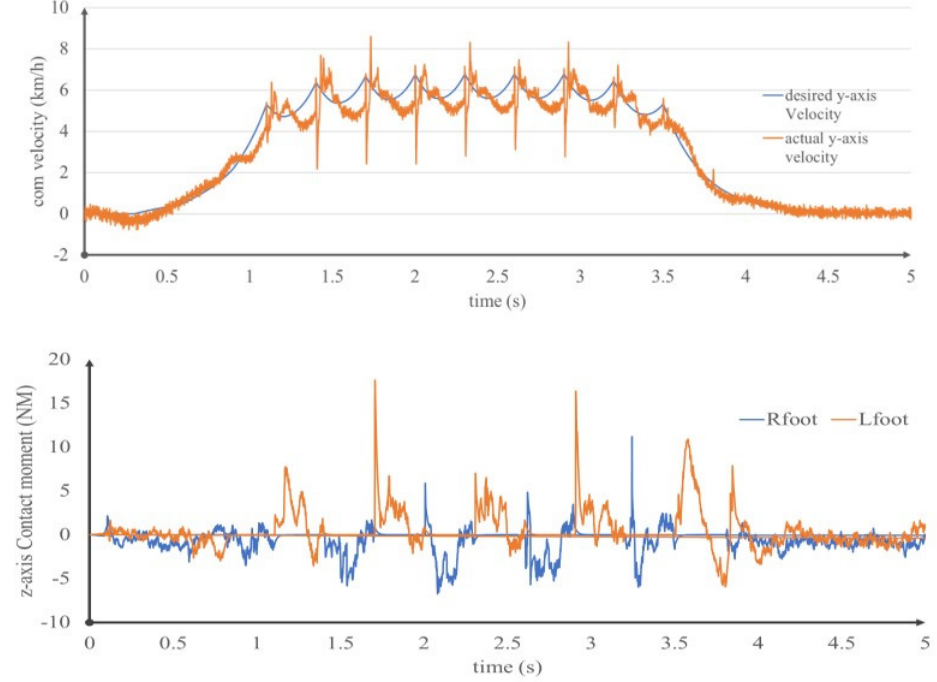
Figure 10. Center of mass (COM) velocity and contact moment in walking at 6 km/h.